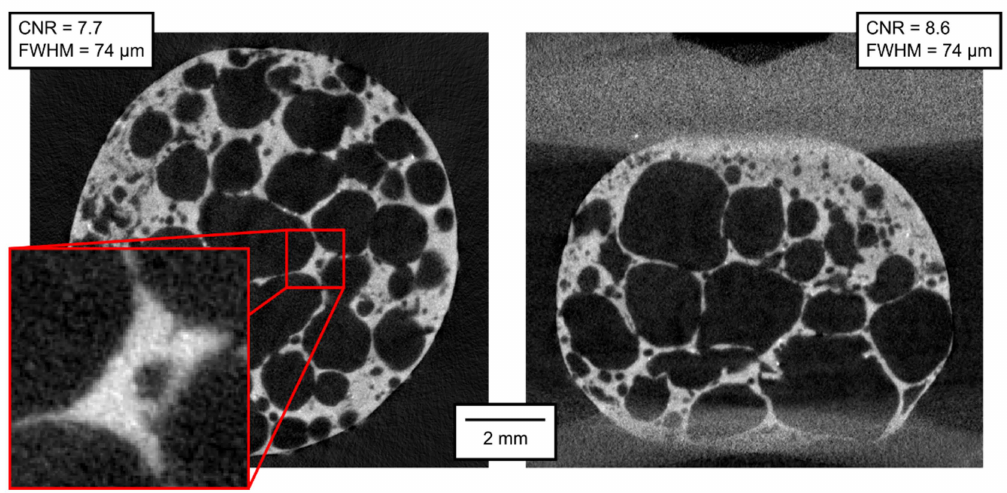
Figure 11. Transversal and lateral central section of the 3D reconstructed volume, Mode